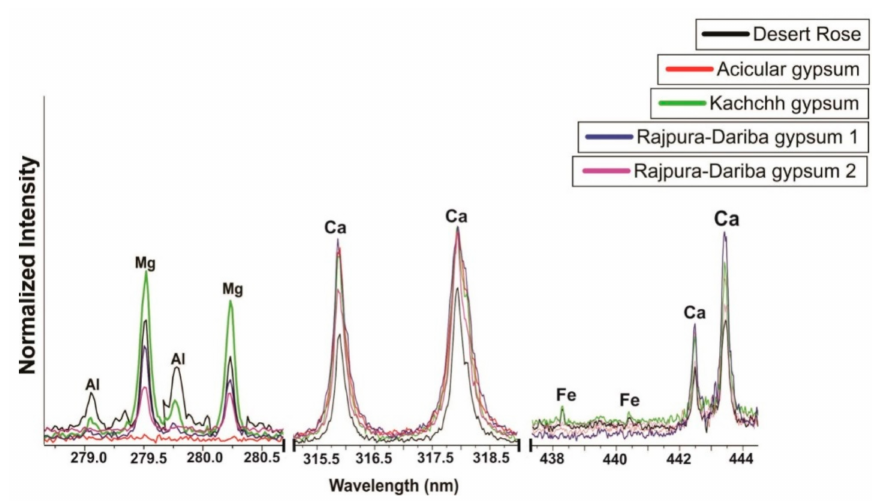
Figure 5. Spectral regions of recorded Al, Mg, Ca, and Fe data for the gypsum samples.